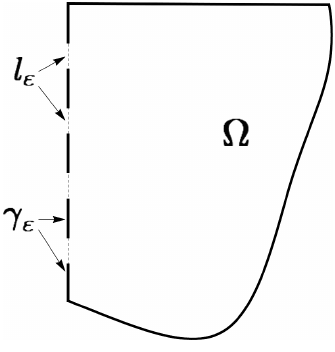
Figure 3: Domain Ω in two